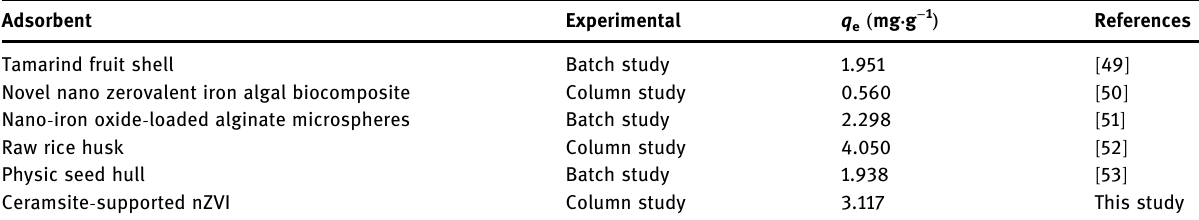
Table 2: A comparative study of the adsorption capacities ( q e ) of MG dye on di ff erent adsorbent materials